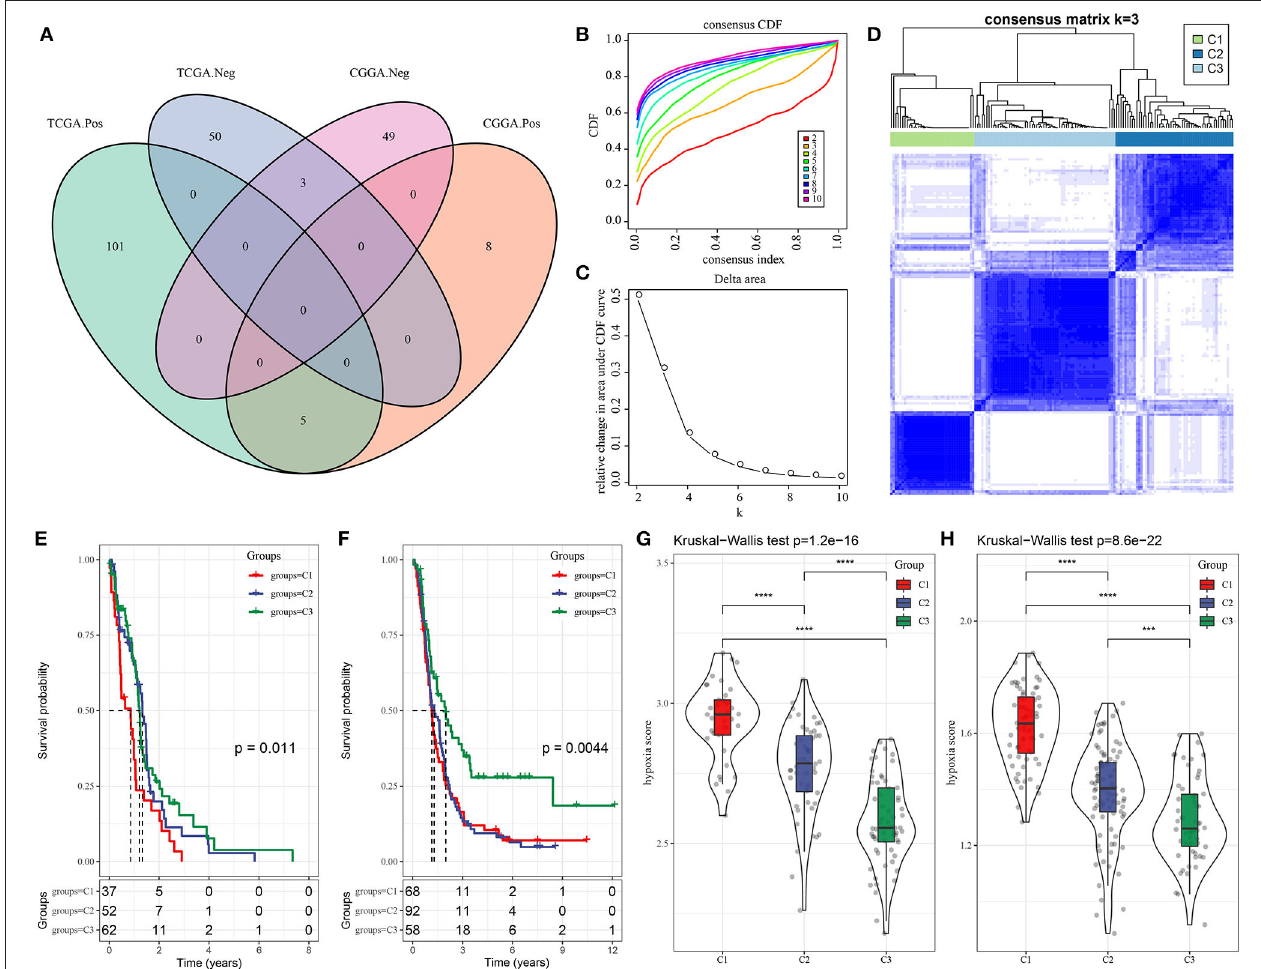
FIGURE 1 | Three molecular subtypes of GBM based on hypoxia-related long non-coding RNAs (lncRNAs). (A) Venn plot of hypoxia-related lncRNA significantly associated with hypoxia score in TCGA-GBM and CGGA-GBM datasets. Pos and Neg represent positive and negative correlations between lncRNAs and hypoxia score. (B,C) CDF curve and relative change in area under CDF curve when cluster number k = 2–10. (D) Consensus matrix when k = 3. (E,F) Kaplan–Meier survival plot of three subtypes in TCGA-GBM and CGGA-GBM datasets. Log-rank test was conducted. (G,H) Hypoxia score of three subtypes in TCGA-GBM and CGGA-GBM datasets. The Kruskal–Wallis test was conducted. Log-rank test was conducted in (E,F) . The Kruskal-Wallis test was conducted in (G,H) . *** P < 0.001, **** p < 0.0001. GBM, glioblastoma; TCGA, The Cancer Genome Atlas; CGGA, Chinese Glioma Genome Atlas; CDF, cumulative distribution